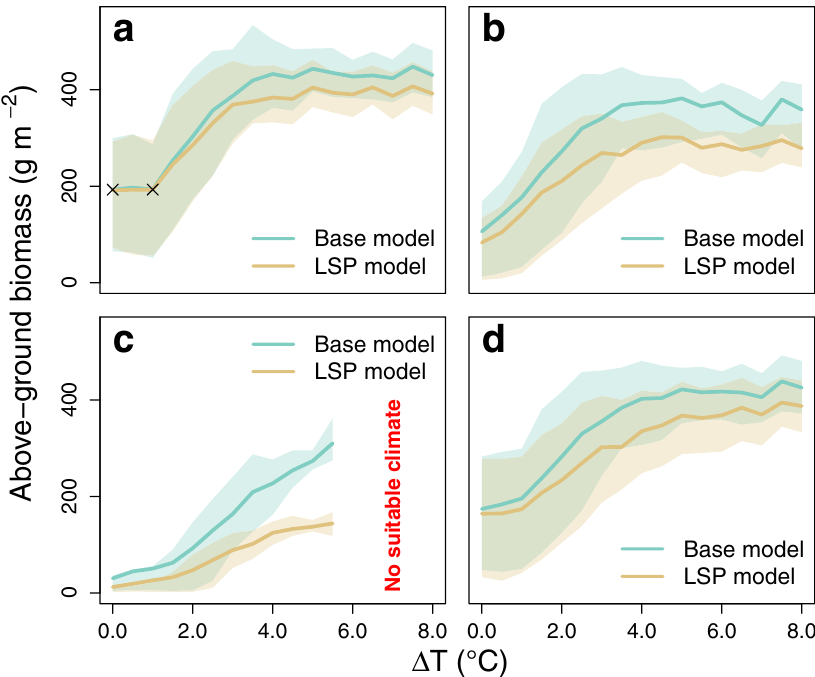
Fig. 3 Cryogenic land surface processes suppress tundra biomass trajectories under climate warming. The above-ground biomass (AGB) predictions over the study area are based on two boosted regression trees (BRT) model con fi gurations: Base model (climate + topography and soil) and LSP model (Base model + cryoturbation, soli fl uction, and nivation). In a – c , cryoturbation, soli fl uction, and nivation are independently considered, respectively; in d , all LSP are considered together. The AGB were extracted from areas suitable for LSP occurrences at each temperature scenario ( 4 T), where monthly air temperatures (averages of 1981 – 2010) were modi fi ed from + 0.5 °C to + 8.0 °C at 0.5 °C interval. The lines depict the means and the shaded areas represent 50% of the predictions. The crosses indicate statistically non-signi fi cant ( P > 0.05) differences between the predictions (a paired one-sided Wilcoxon ’ s